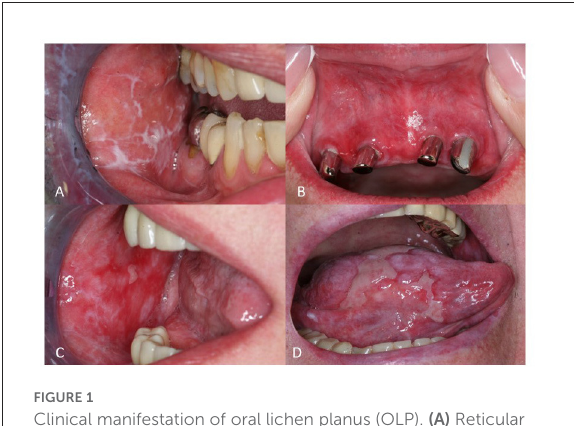
FIGURE1 Clinical manifestation of oral lichen planus (OLP). (A) Reticular OLP with characteristic Wickham’s striae (B) Erythema in a female patient with OLP (C) Multiple erosions on the left buccal mucosa in a patient with erosive OLP (D) Extreme painful ulcerations of the tongue in a patient with ulcerative